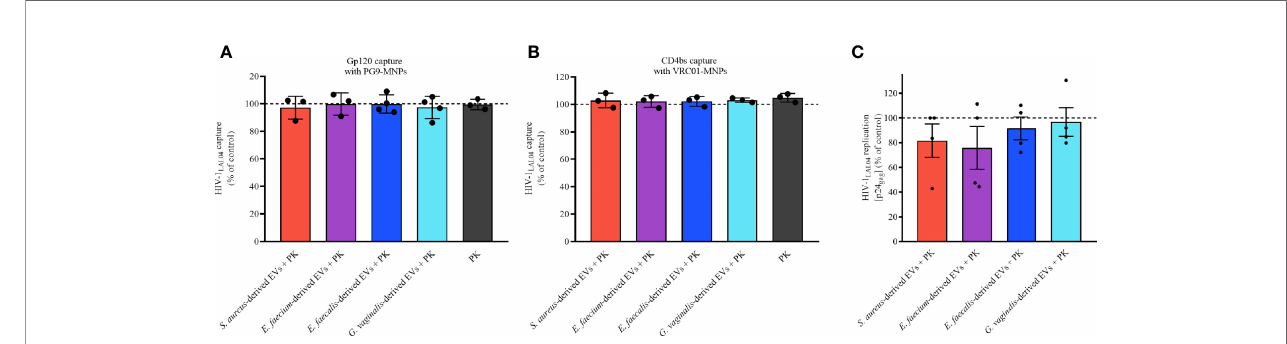
FIGURE 8 | Bacterial EV-associated protein role during HIV-1 infection. The proteins associated to bacterial EVs were digested with PK followed by an ulterior ultracentrifugation to obtain bacterial EVs free of surface proteins. HIV-1 LAI.04 was pre-treated with 1×10 10 PK-treated EVs derived from S. aureus , E. faecium , E. faecalis , or G. vaginalis , or with PK (PBS treated with PK and puri fi ed by ultracentrifugation), or with PBS (control) for 1h. Next, HIV-1 LAI.04 virions were captured with PG9 (A) or VRC01 (B) antibodies. Also, the antiviral effect of PK-treated bacterial EVs in MT-4 cells infected with HIV LAI.04 was evaluated (C) . The amount of virus captured and the amount of virus present on cell culture medium were determined from measurement of the levels of viral p24 gag . Data are presented as percentages of p24 gag concentration compared with the control (PBS). Presented are means±SEM from three independent measurements. Statistical analysis was performed with one-way ANOVA multiple